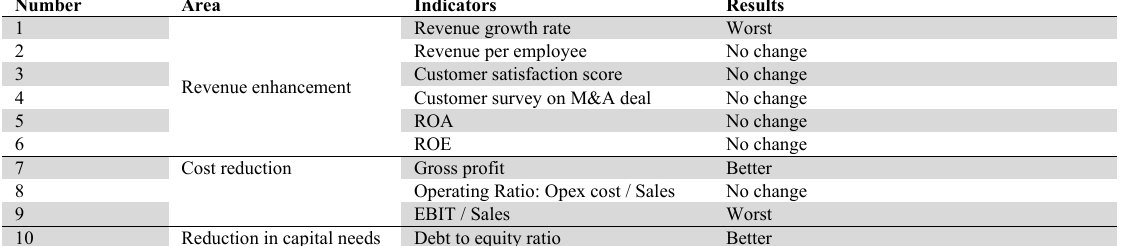
The summary of synergy indicators before and after M&A - Pair sample t-test